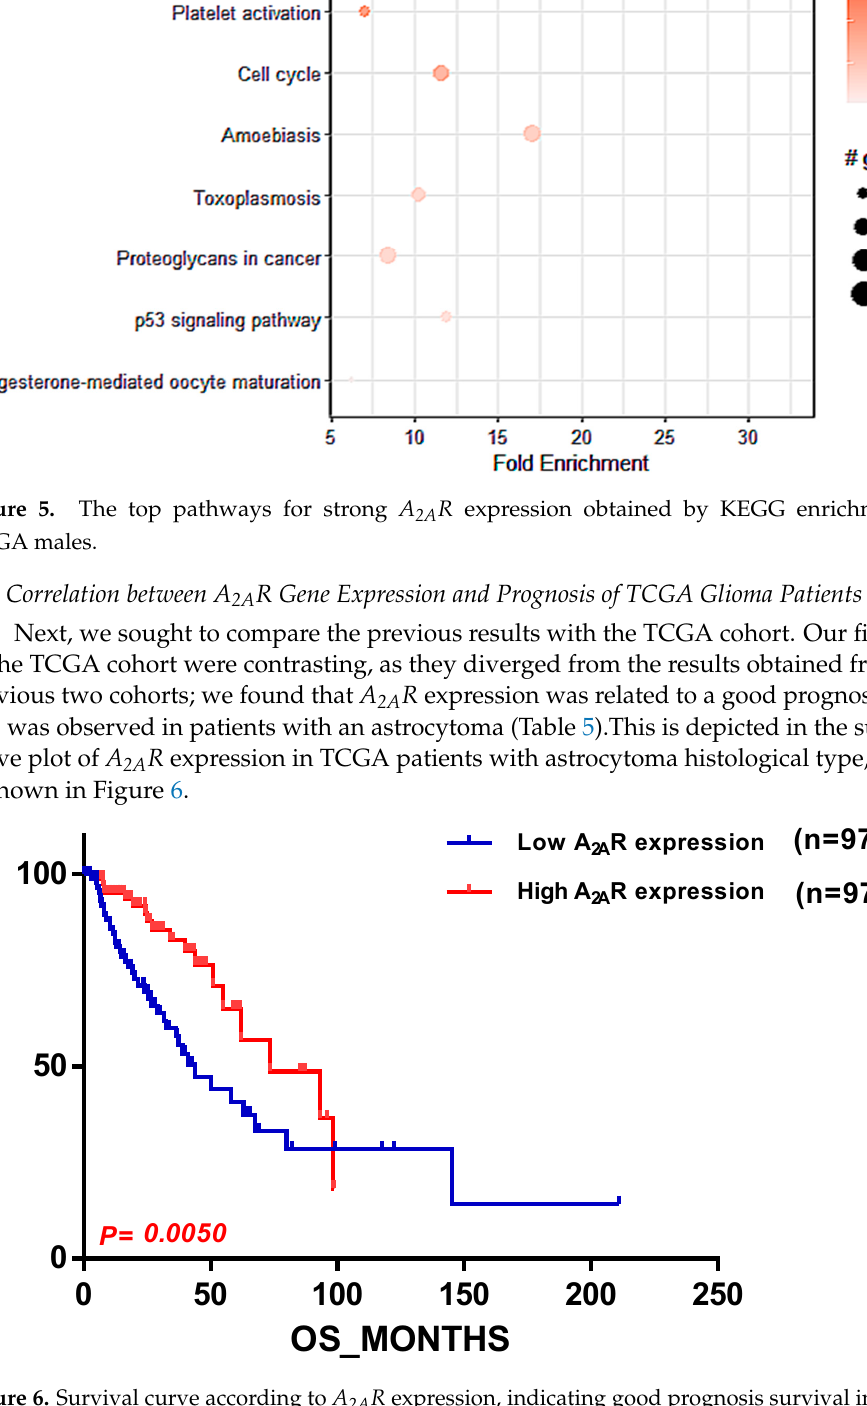
Table 5. A 2A R gene expression was associated with good prognosis in TCGA astrocytoma patients.